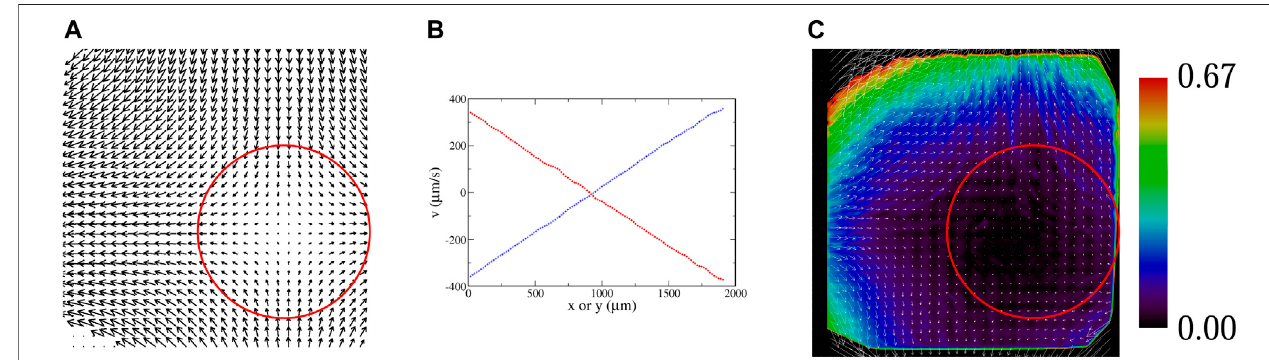
FIGURE5|(A) Experimental velocity fi eld,determinedwithpassivetracers; fl owrate200 μ l/min,A=3.6 s − 1 .Theredcircleshowstheregionofinterestused forall ofthestatisticalanalysesofmicrobedata. (B) Slicesofthevelocity fi eld; u x alongahorizontallinethroughthe fi xedpoint(blue),and u y alongaverticallinethroughthe fi xed point(red).Thesecurvesare fi ttoalinetodetermine A in Eq.1a , Eq.1b . (C) Vector fi eldshowingthedeviationoftheexperimentally-measuredvelocity fi eldfromanideal hyperbolicvelocity fi eld Eq.1a , Eq.1b ;i.e., Δ (cid:2) v (cid:1) (cid:2) v exp − (cid:2) v ideal .Thearrowsarescaledupbyafactorof fi velargerthanthosefor Figure5A .Thecolormapshowsthe magnitude | Δ (cid:2) v | / 〈 v 〉 of the velocity deviations, normalized by the average fl ow speed.